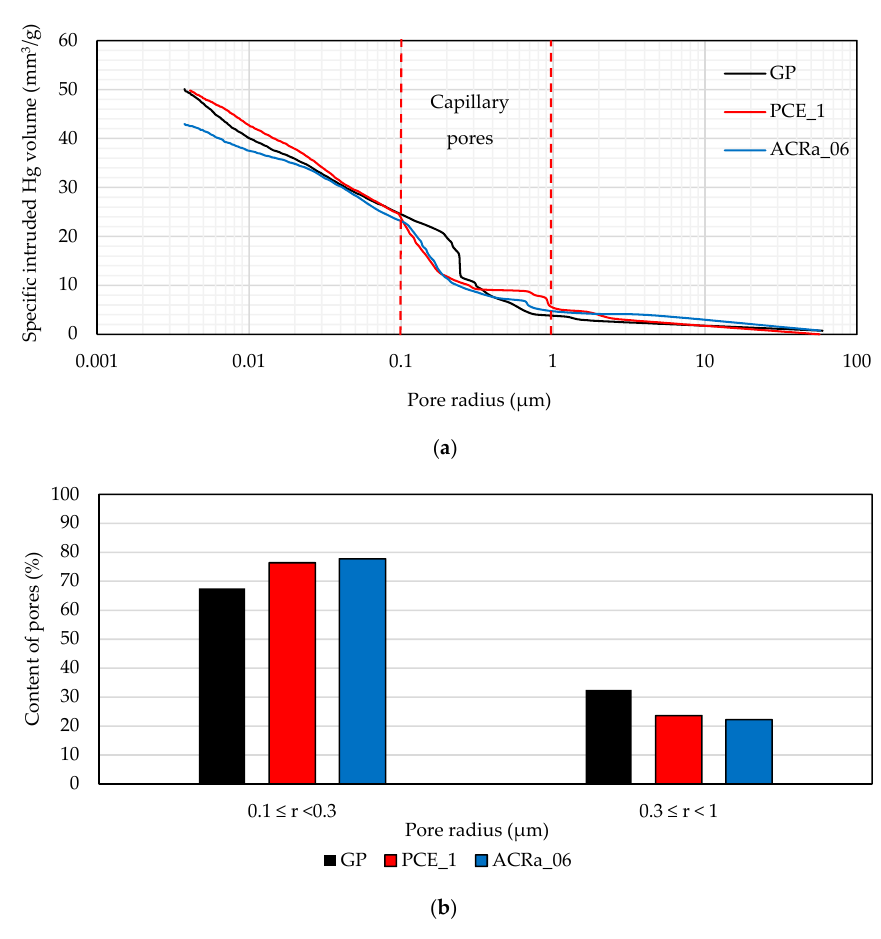
Figure 7. ( a ) Pore size distributions curves of the investigated geopolymer mortar samples; ( b ) content % of pores arranged per ranges of pore radius ( r ) within the range of 0.1 ≤ r < 1 μ m.